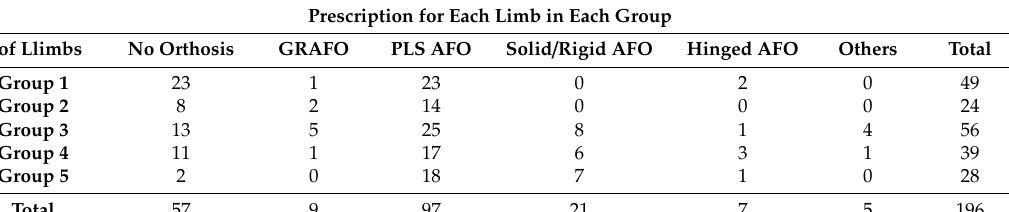
Table 1. Limb distribution in each group with the prescribed orthosis (#: number). Prescription for Each Limb in Each Group